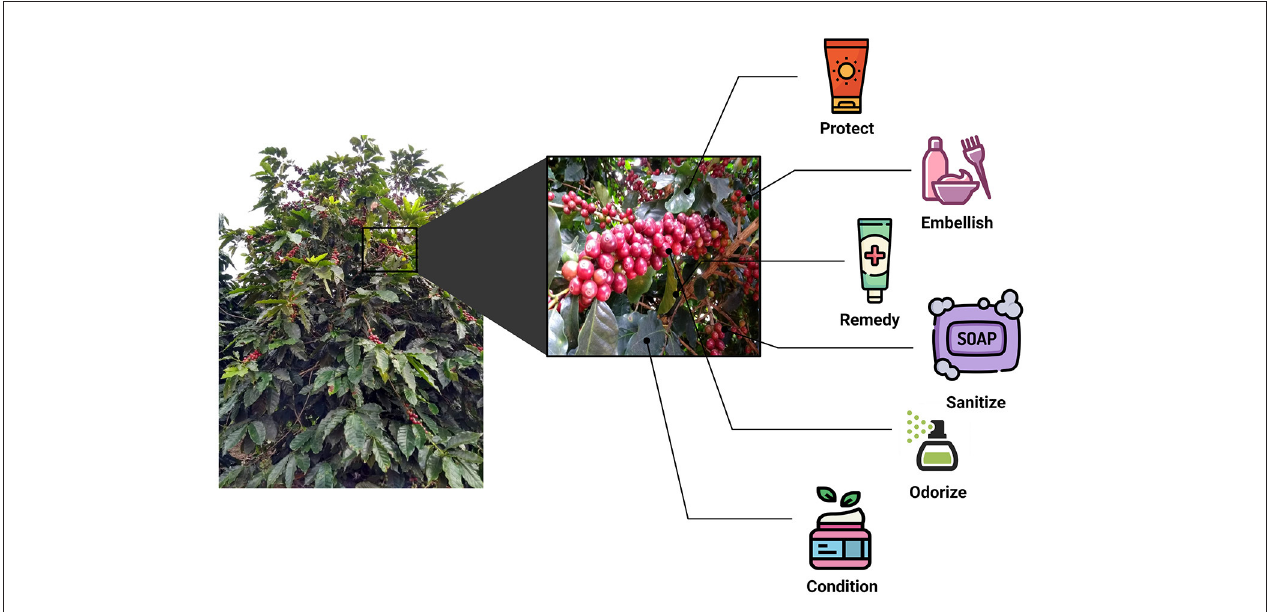
FIGURE 4 | Schematics of main cosmetic applications of coffee bean plant extracts. Created with BioRender.com. This schematic explores applications of coffee phytochemicals in personal care products using the PERSOnal Care products and ingredients classification (PERSOC) (see Figure 2